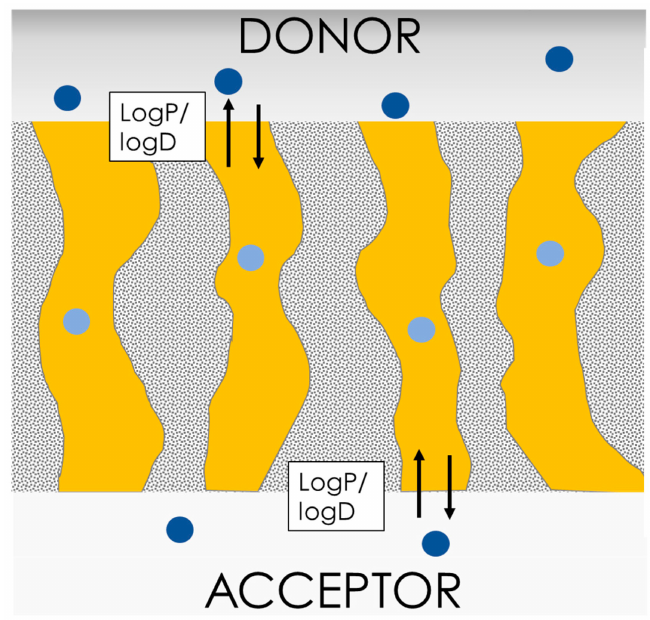
Figure 9. Schematic representation of the PAMPA barrier structure. The PAMPA barrier is a porous filter (0.22–0.45 µ m pore size) that is soaked with a lipid mixture (yellow section). The rate-limiting step, controlling permeability, in this case consists mainly of the solute partition/distribution co- efficient (LogP/logD) and the diffusivity in the lipid barrier (D B ). In the case of electrolytes, the molecules need to be neutralized (light blue dots) and then re-gain their charge once in the acceptor.